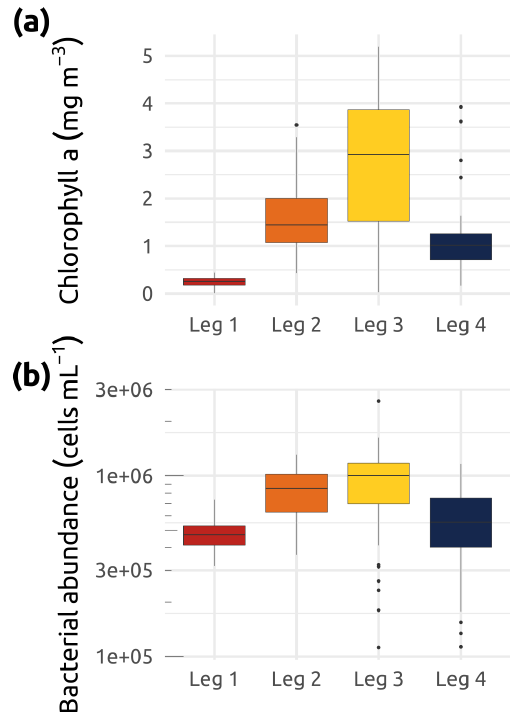
Figure 10. Box plots of (a) chlorophyll a (Chl a ) concentration (mgm − 3 ) and (b) bacterial abundance (cells in mL − 1 ) for the four WP4 Nunataryuk expeditions (Legs 1, 2, 3, and 4) in 2019. Boxes represent the interquartile range (IQR), the horizontal lines show the medians, while the vertical lines show data spread with min/max whiskers. Notice the y -axis log10 scale. Also note that a few data points below 100K (Leg 2) were excluded from panel (b)